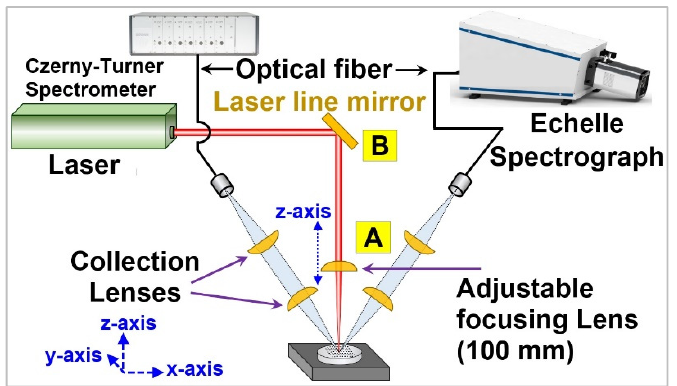
Figure 1. A simplified schematic of the LIBS system used in the experiment. For each laser wavelength, the set of laser mirrors ( B ) were changed, and laser focusing lens ( A ) was adjusted.